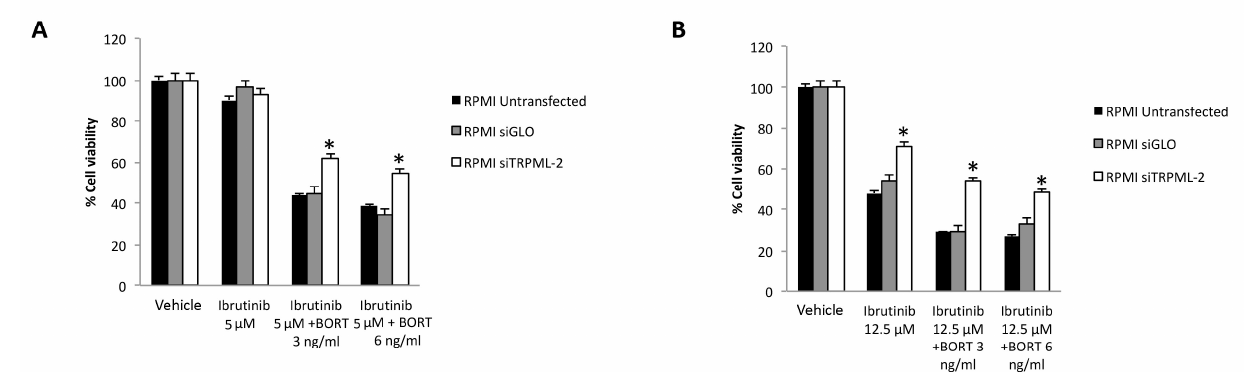
Figure 9. Cell viability assay in untransfected, siGLO and siTRPML2 RPMI cells treated for 48 h with Ibrutinib 5 μ M ( A ) or 12.5 μ M ( B ) in combination with Bortezomib (BORT). Data are the mean ± SD of three different experiments. * p < 0.05 vs. siGLO and untreated cells.